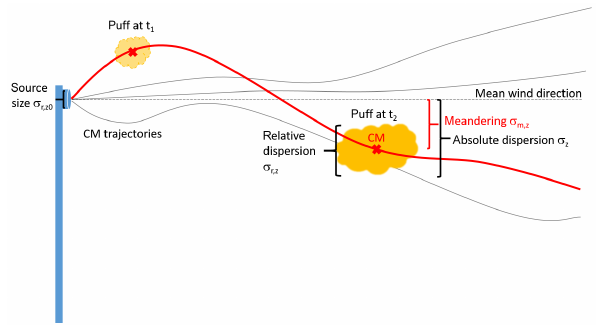
Figure 4. Sketch of a puff release. The centre of mass trajectory of a single puff (red) meanders around the mean trajectory of a puff ensemble, while the puff additionally spreads around its centre of mass. Consequently, the absolute dispersion can be separated into the meandering of the centre of mass trajectories and the variance of the puffs’ concentration relative to their centre of mass. Both are obtained using data from a large number of realizations of single puff